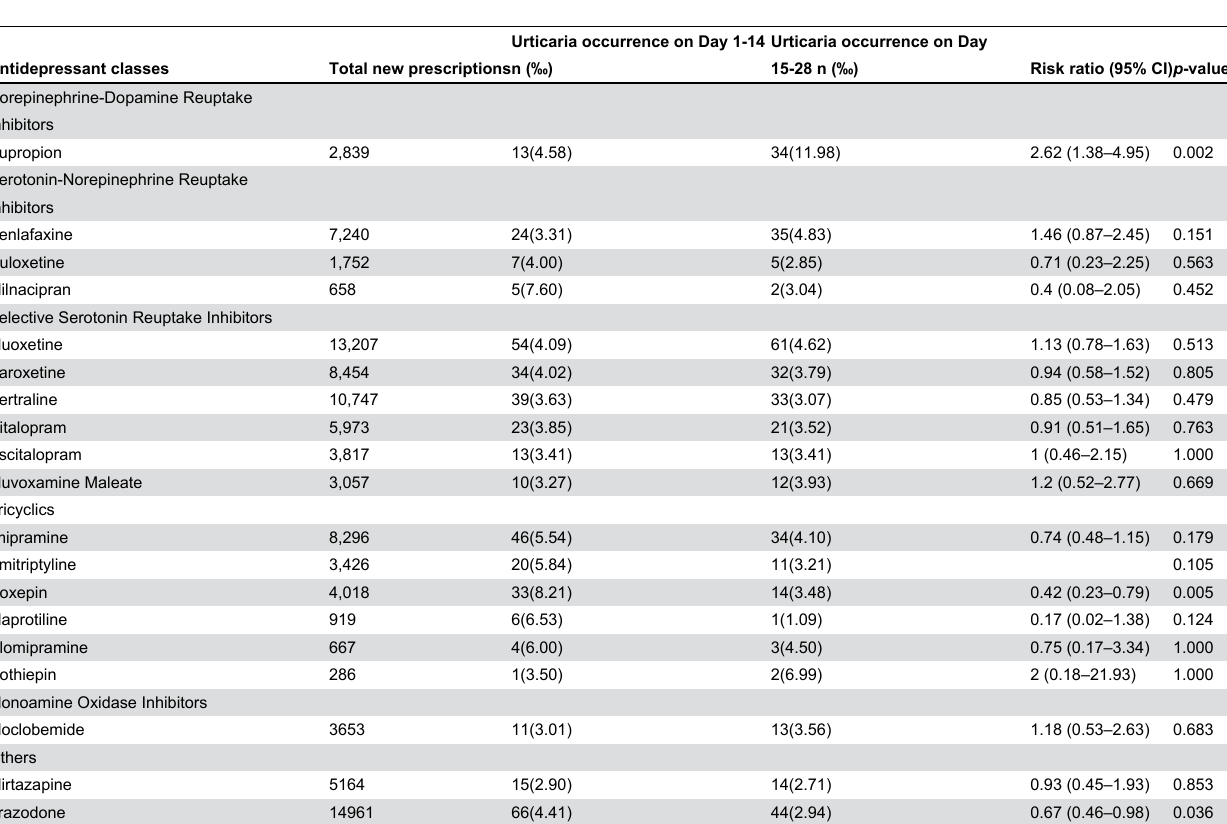
Table 5. The risk of urticaria occurrence among all antidepressant classes.